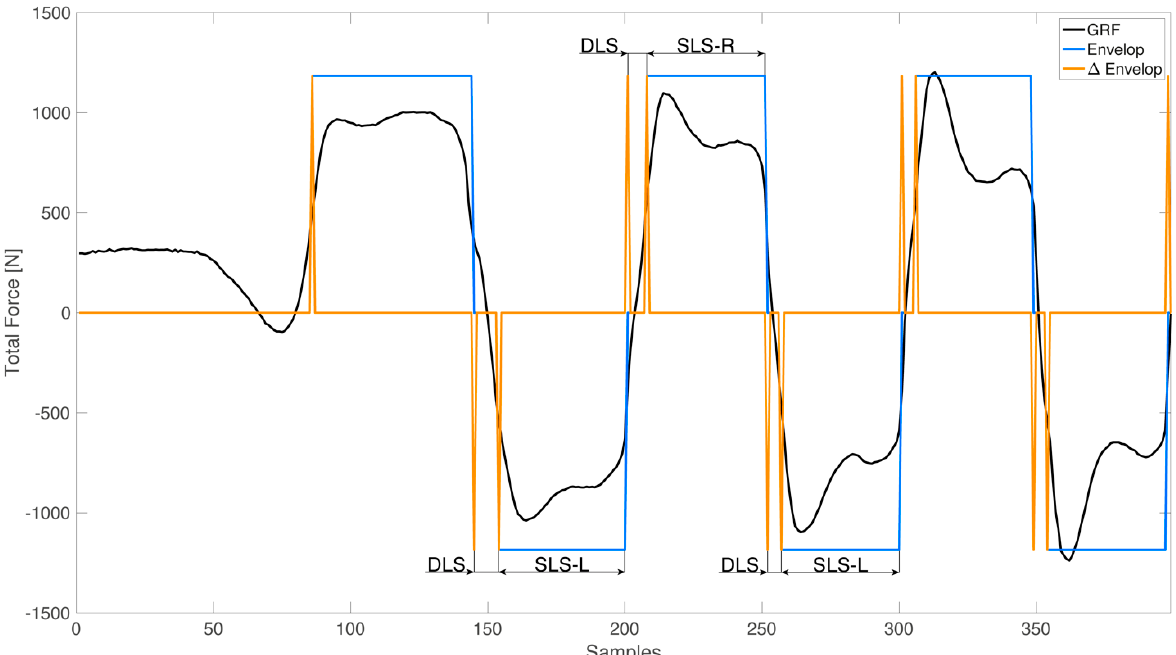
Figure 3. Segmentation of the gait cycle implemented using the differential ground reaction force (GRF) between total right force and total left force. DLS: double limb support, GRF: ground reaction force, SLS-L: left single limb support, SLS-R: right single limb support.